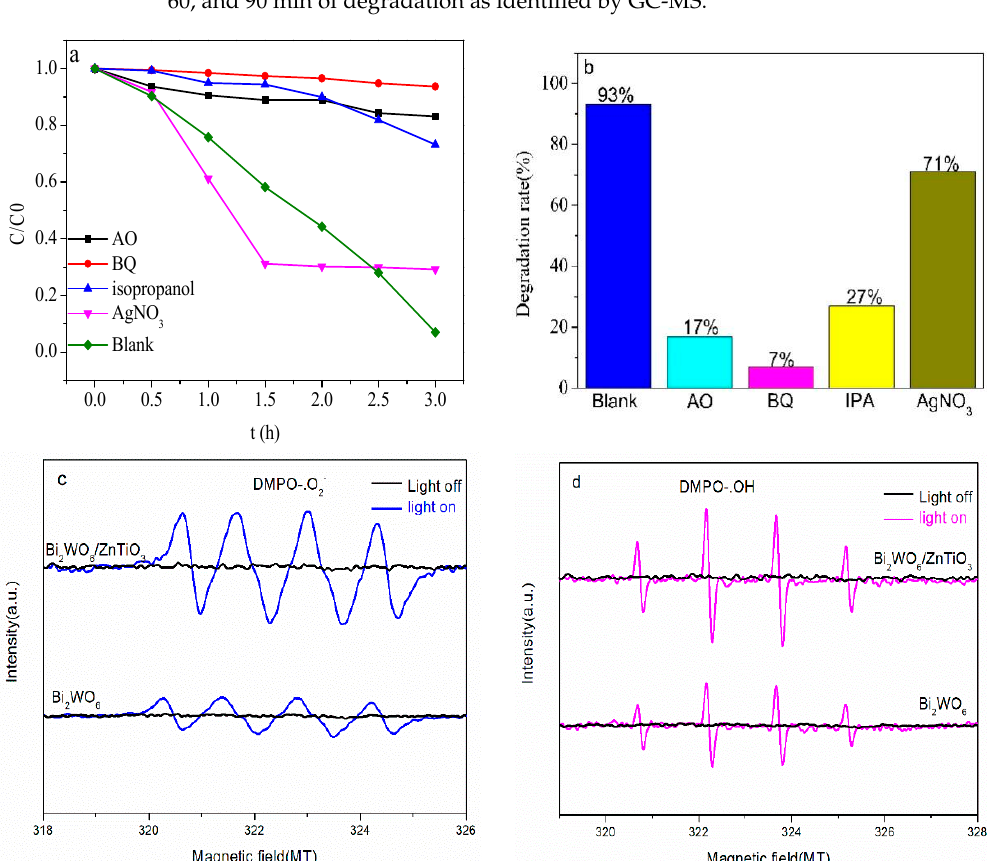
Figure 9. E ff ect of quencher on phenol degradation rate. ( a ) Degradation curve diagram, ( b ) histo- gram of degradation rate, ( c ) DMPO-. O 2 − , and ( d ) DMPO-.OH spin-trapping ESR spectra for Bi 2 WO 6 togram of degradation rate, ( c ) DMPO-.O 2 − , and ( d ) DMPO-.OH spin-trapping ESR spectra for and Bi 2 WO 6 /ZnTiO 3. Bi 2 WO 6 and Bi 2 WO 6 /ZnTiO 3